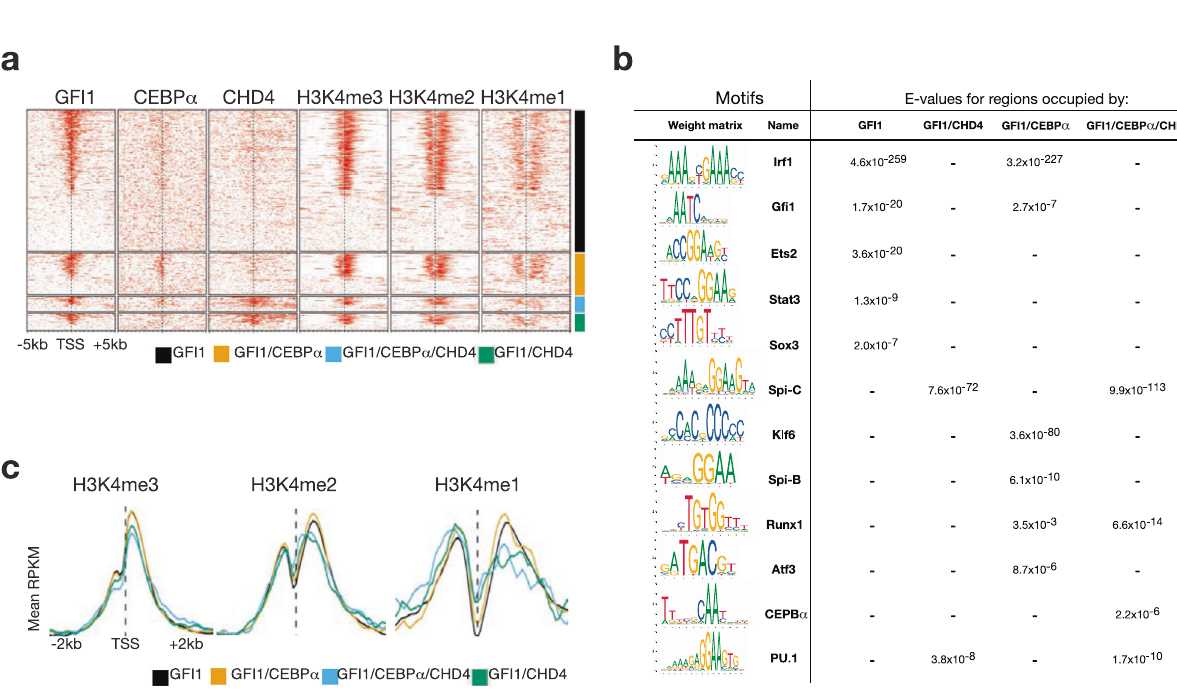
Fig. 5 De novo motif analysis and histone methylation aggregation plots for sites occupied by GFI1, CHD4, and CEBP α in GMPs. a Comparison of ChIP- seq data for the occupation of GFI1, CHD4, and H3K4 methylation at promoter regions in GMPs with an analogous ChIP-seq data set for the transcription factor CEBP α . Data are ordered according to GFI1 occupation and are separated into four groups: occupation by GFI1 alone, by GFI1/CEBP α , by GFI1/ CEBP α /CHD4, and by GFI1/CHD4. b De novo motif analysis of consensus DNA binding sites at promoter regions by GFI1 alone, by GFI1/CEBP α , by GFI1/ CEBP α /CHD4, and by GFI1/CHD4. c ) Aggregation plots of histone H3K4 methylation at promoters as de fi ned in ( a ) for regions 2 kb 5 ′ or 3, of the TSS (transcription start